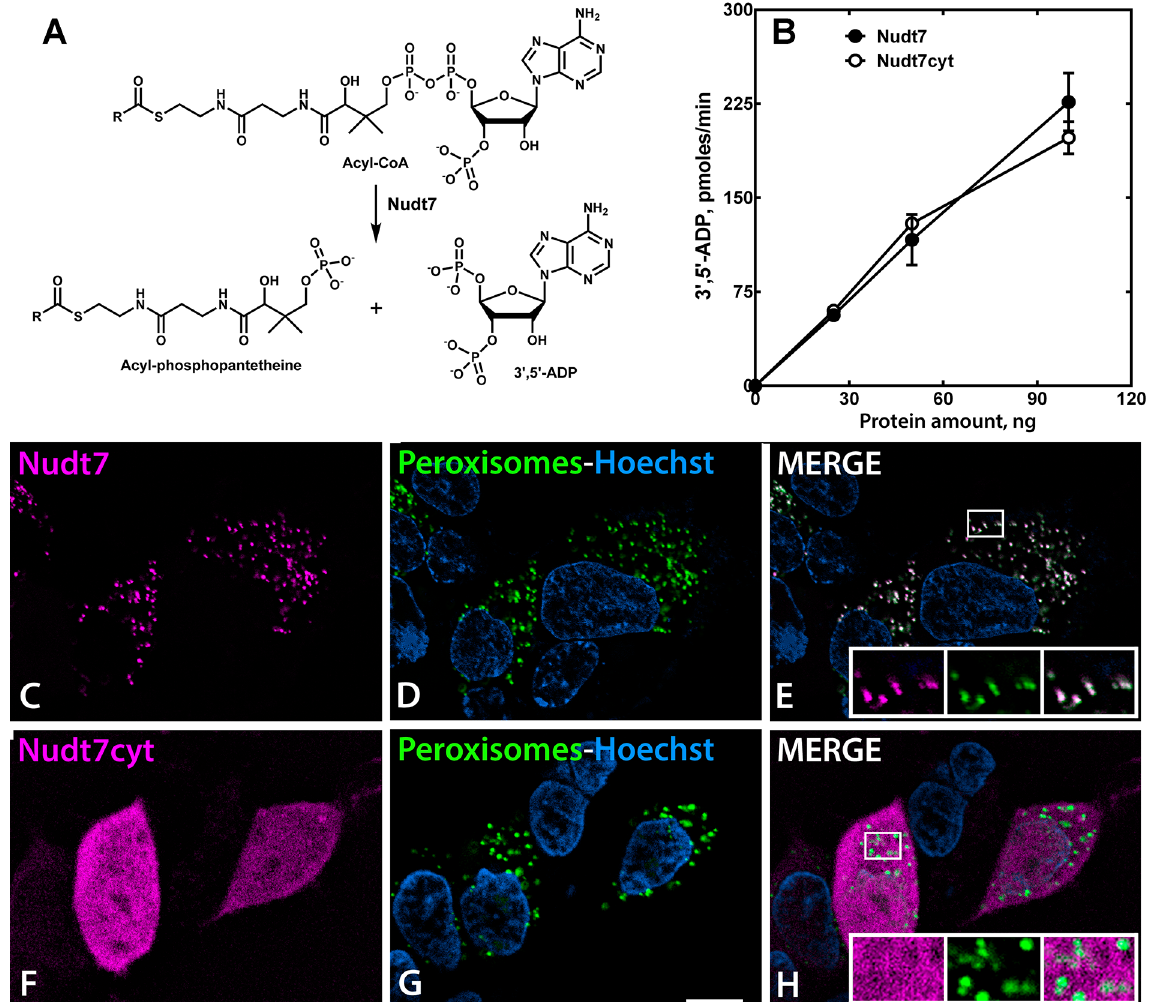
Fig 1. Nudt7 and Nudt7cyt activity and localization. (A) Nudt7 hydrolyzes the phosphodiester bond in acyl-CoA species producing acyl- phosphopantetheine and 3 ’ ,5 ’ -ADP. (B) Enzymatic activities of purified mouse Nudt7 (closed circles) and Nudt7cyt (open circles). Data are reported as the mean ± the range. (C-H) HEK293 cells were transfected with expression plasmids encoding mCherry fused to the N-terminus of Nudt7 (C-E) or Nudt7cyt (F-H) as described in ‘ Material and Methods ’ . mCherry-Nudt7 and mCherry-Nudt7cyt proteins are shown in magenta (C, F) and cell nuclei are stained with Hoechst 33342 in blue (D, E, G, H). Co-transfection with a plasmid encoding green fluorescent protein (GFP) with a C-terminal SKL (GFP-SKL) (D, G) designates the peroxisomes shown in green. GFP-SKL colocalizes with Nudt7 (E, shown in white) but not with Nudt7cyt (H). The mCherry-Nudt7, mCherry- Nudt7cyt and GFP-SKL proteins were visualized by live-cell confocal fluorescent microscopy. Scale bar, 10 μ m.